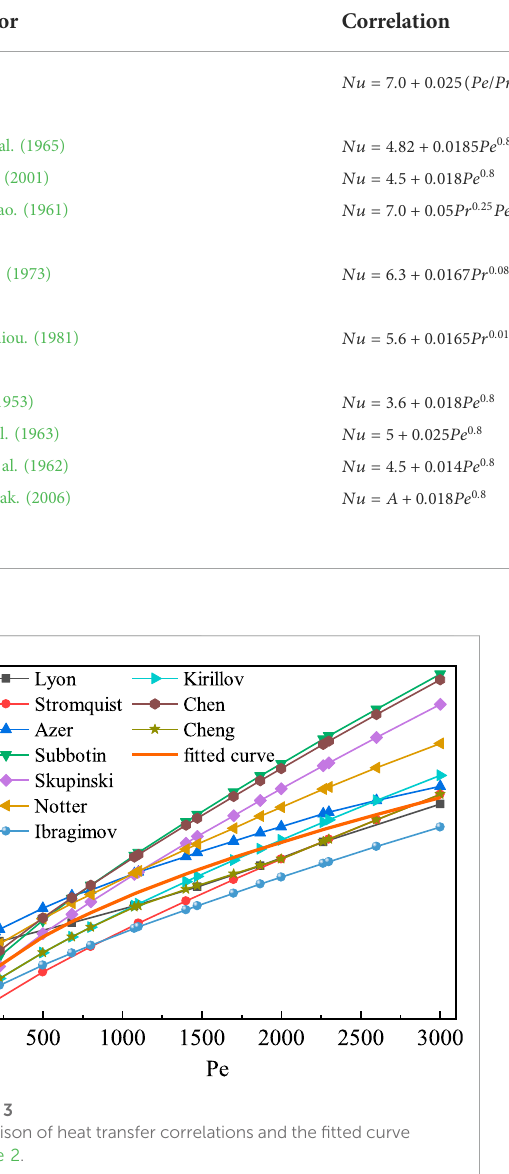
Figure 2. The correlations proposed by scholars are